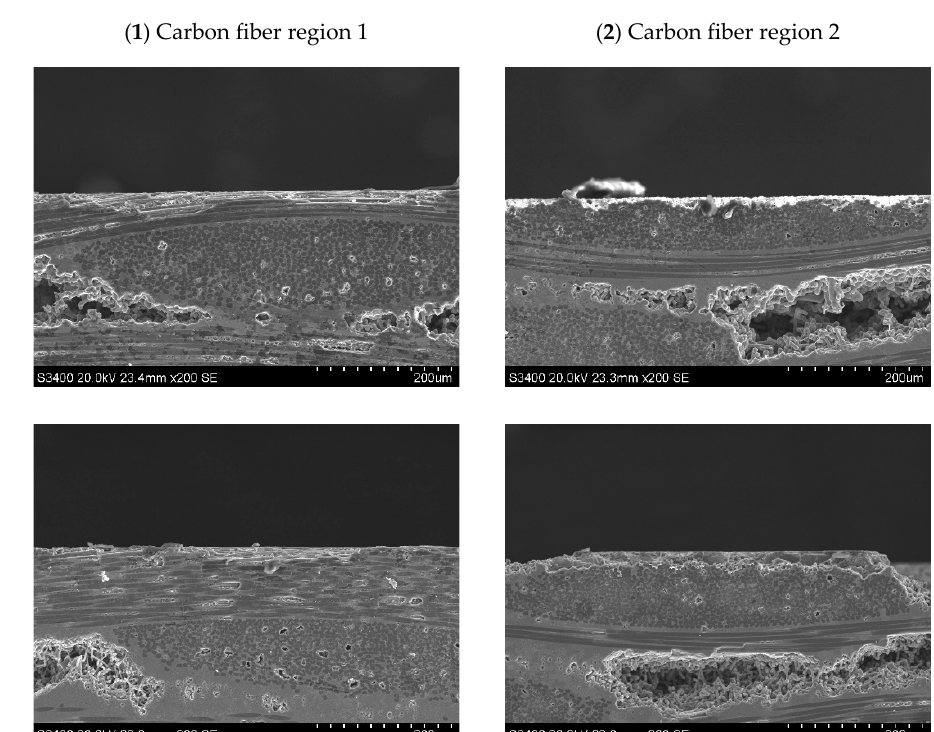
Figure 23. Subsurface morphologies of the C/SiC composite material after common grinding and